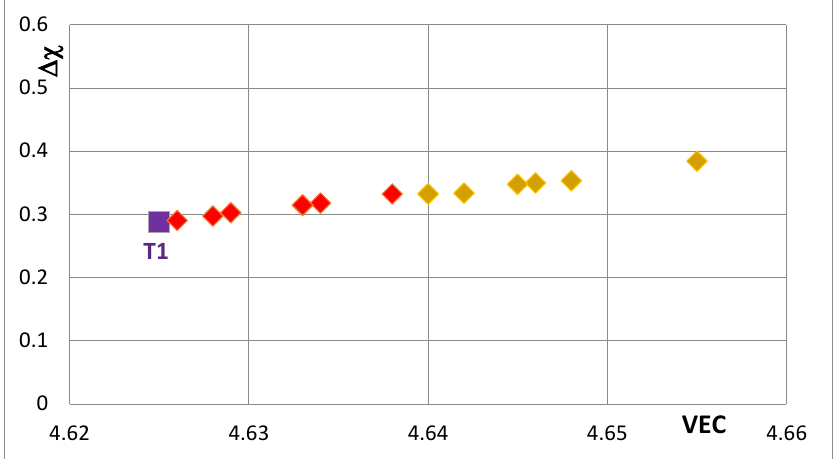
Figure 6. ∆ χ versus VEC map of Nb 5 Si 3 that shows the effect of the substitution of Si by Sn or Ge on the position of the silicide in the map. The Nb 5 Si 3 (T1), Nb 5 (Si,Sn) 3 and Nb 5 (Si,Ge) 3 are shown respectively by purple square and by red and gold